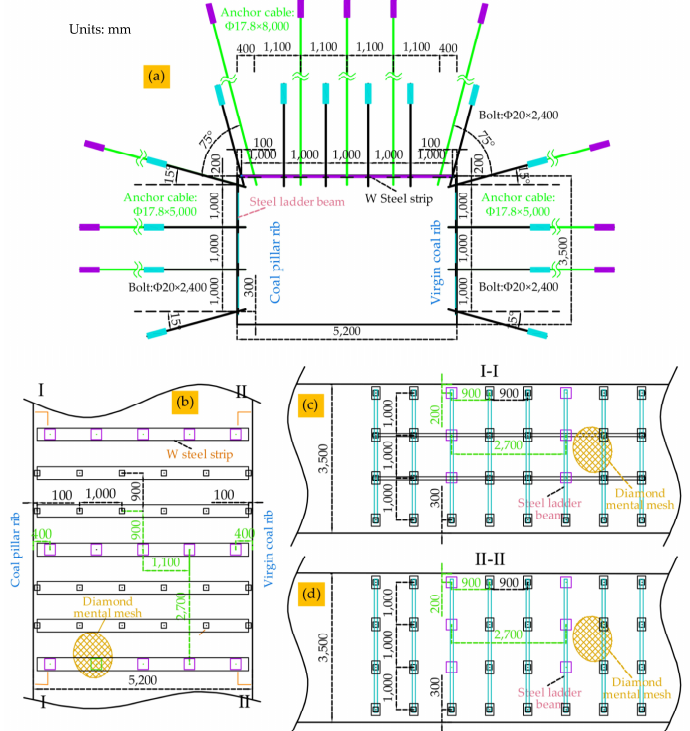
Figure 14. Detailed support parameters. ( a ) Entry section. ( b ) Support pattern in roof. ( c ) Support pattern in coal pillar rib. ( d ) Support pattern in virgin coal rib.